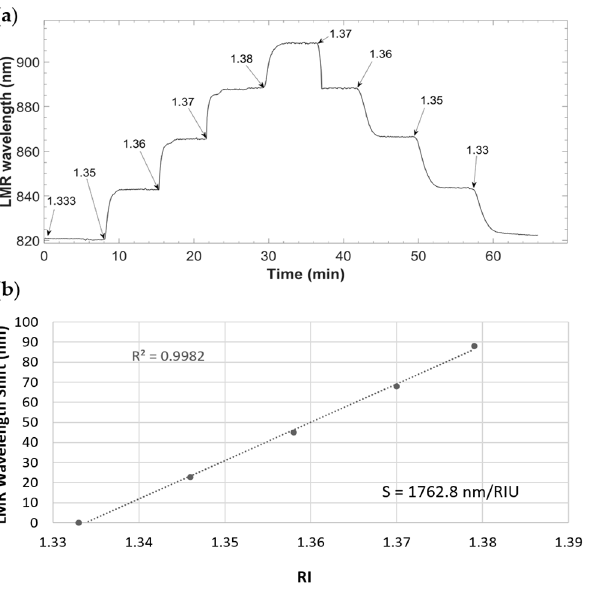
Figure 8. System response to the circulation of different refractive index glucose solutions: ( a ) sensorgram of different RI glucose solution detection, and ( b ) calibration curve of the sensor.